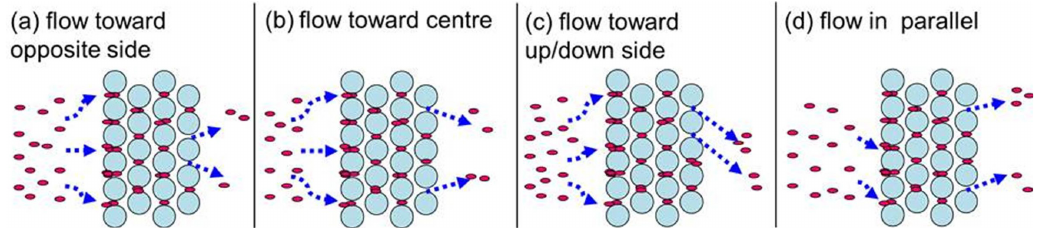
Figure 4. Schematic illustrations of random release process. The direction and rate of flow change in different ways. ( a ) The cells flow toward the outer sides. ( b ) The cells move toward the central area of the microchamber. ( c ) The cells flow upward/downward when released from the lower/upper gaps. ( d ) The cells flow in parallel when the timing and direction of their release are identical. Blue arrows indicate the direction of cell